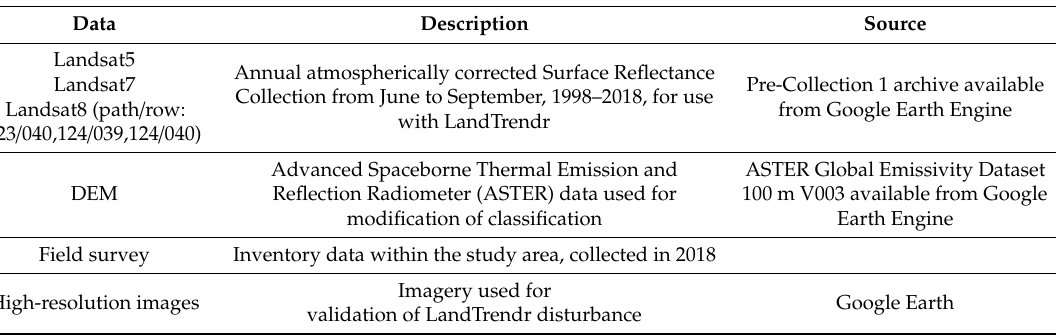
Table 1. Datasets used in this study.